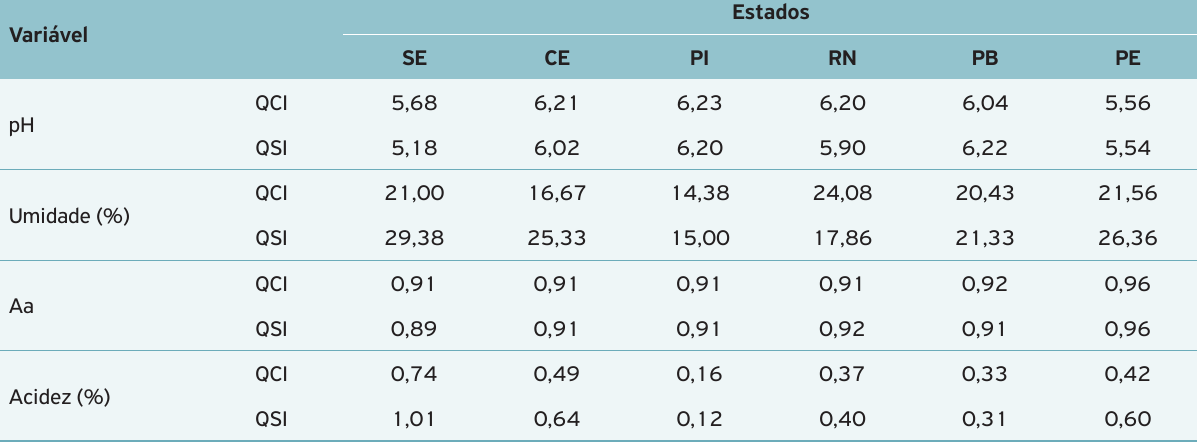
Tabela 1. Valores médios das análises físico-químicas do queijo de coalho comercializado em seis estados da região nordeste de acordo com tipo de produção, com inspeção ou sem